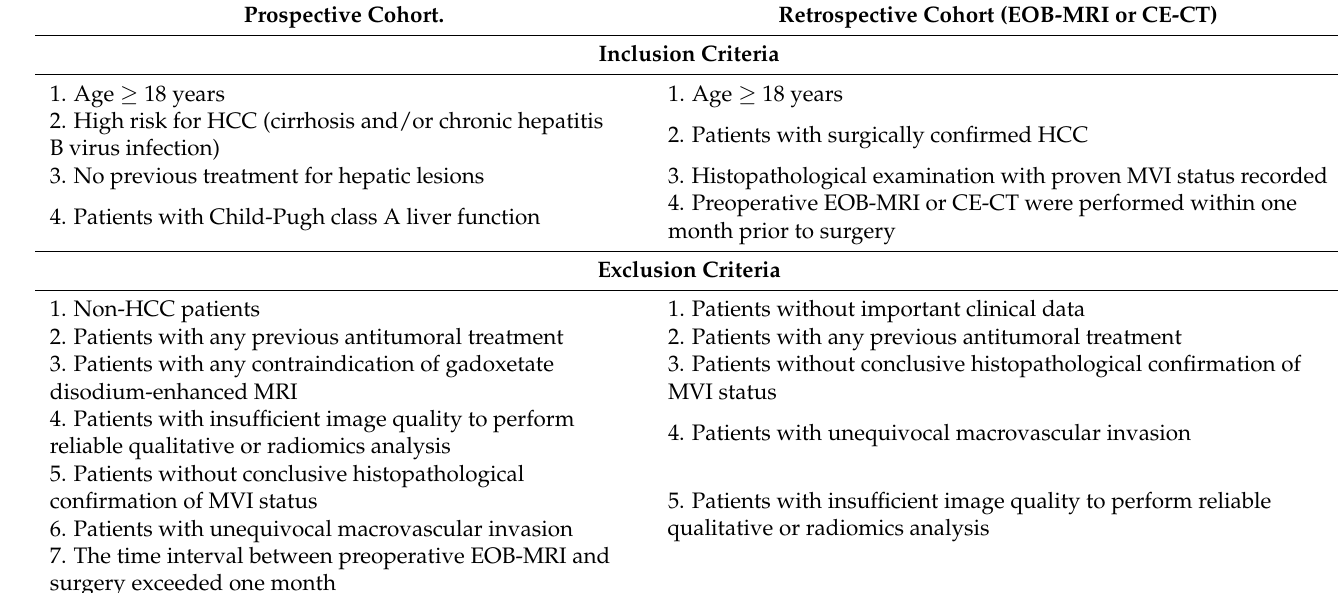
Table 1. Eligibility